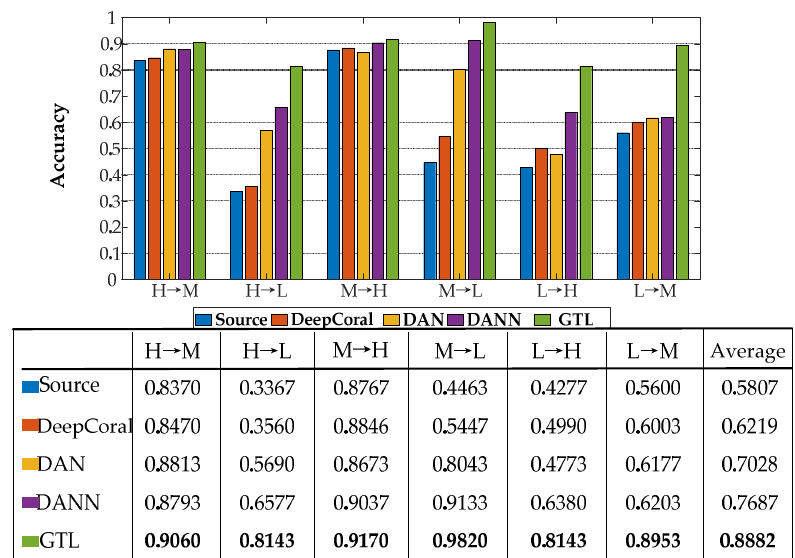
Figure 6. Accuracy (%) of the GTL method across three working load domains compared with other four other methods.